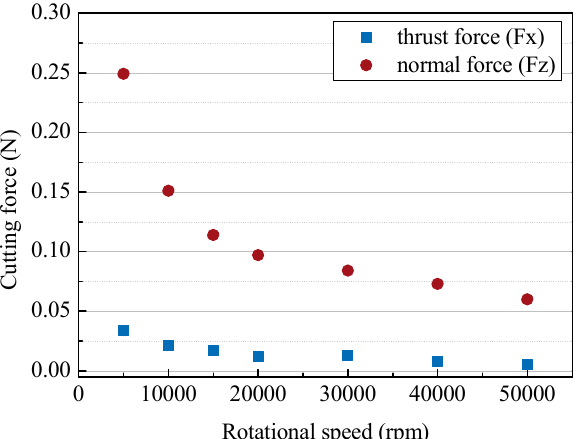
Figure 9. The cutting forces with different rotational tool speeds (250 µ m/s; depth of cut: 5 µ m).